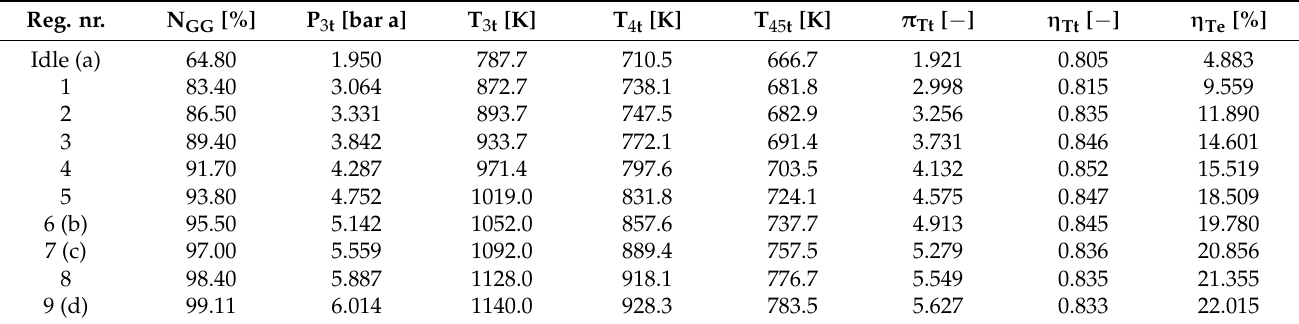
Table 5. Calculated data at each engine working regime, part one.